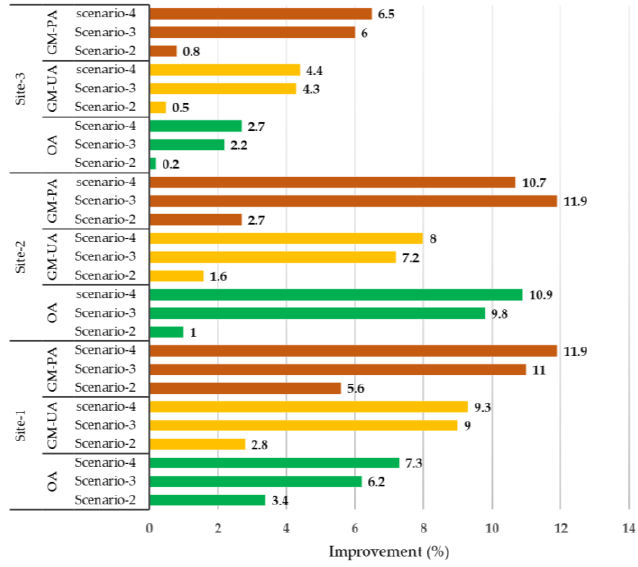
ff erent Scenarios on MLC classification Figure 12. Impacts of different Scenarios on MLC classification accuracy. Figure 12. Impacts of di